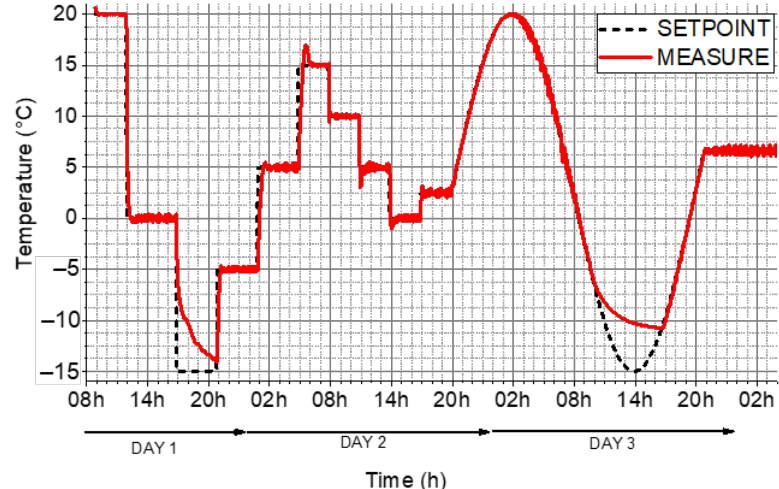
Figure 4. Air temperature evolution in the cold chamber.